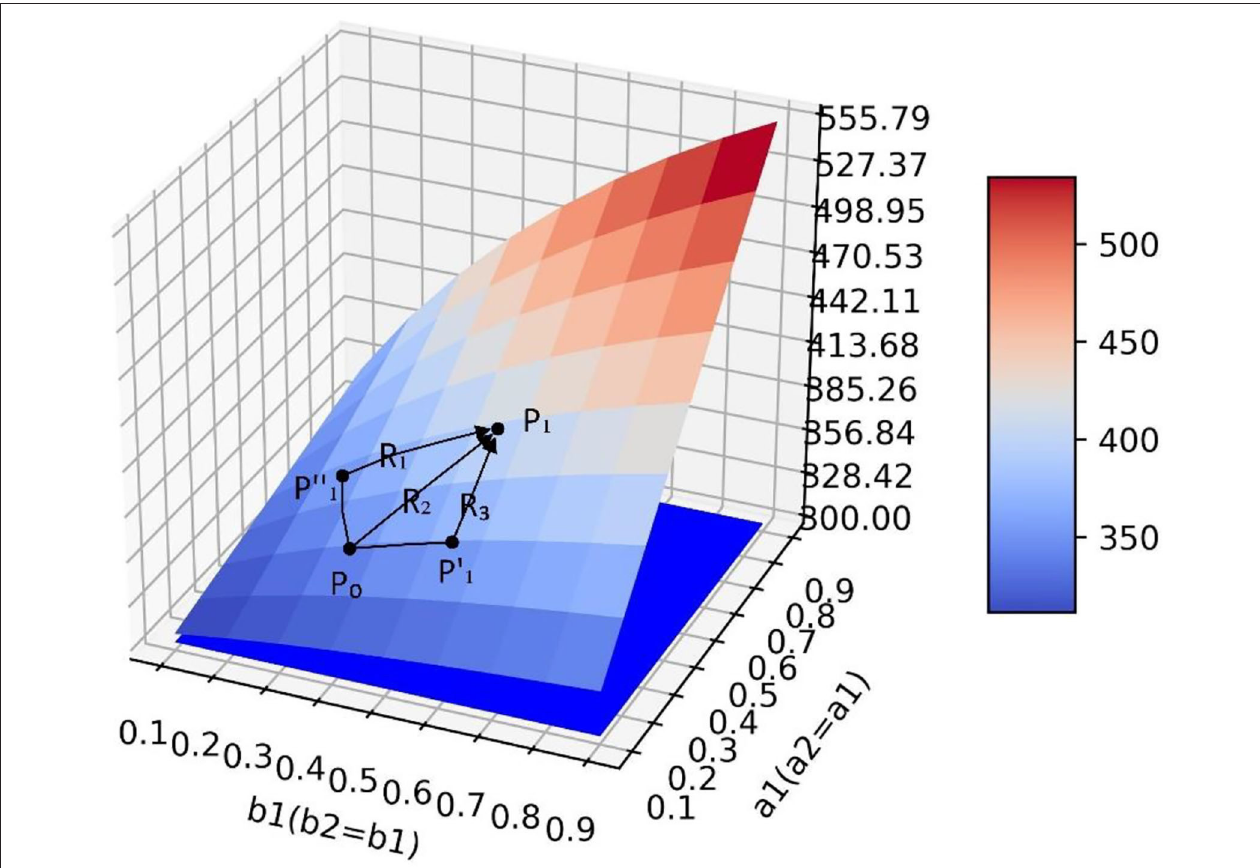
FIGURE 12 | Different policy paths on the